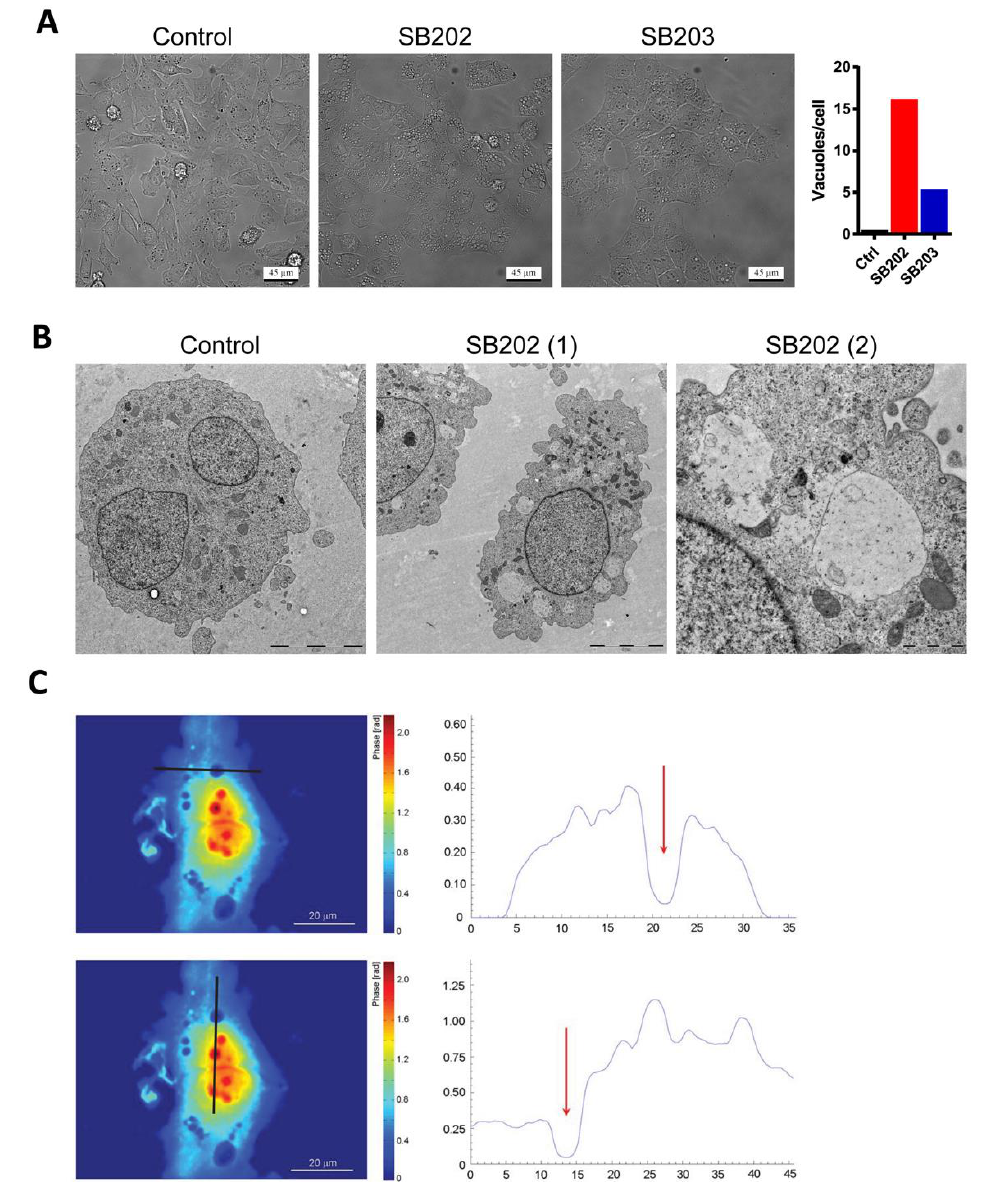
Figure 2. Pyridinyl imidazole compounds induce vacuolization of cytoplasm in BRAF-mutated human melanoma cells. A375 cells were treated with DMSO (control), SB202190 (SB202; 10 µ M), and SB203580 (SB203; 10 µ M). ( A ) Phase-contrast light microscopy of living cells after 12 h treatment with pyridinyl imidazole p38 MAPK inhibitors. Scale bar: 45 µ m. The representative graph shows the mean number of vacuoles per cell quantified using ImageJ / Fiji (find maxima—bright spots above a certain threshold). Dying rounded cells were excluded from the analysis. Similar results were obtained in three independent experiments. ( B ) The content of vacuole-like vesicles was visualized by electron microscopy 24 h post-treatment with SB202190 (SB202). Control and SB202(1)—scale bar 5 µ m. SB202(2)—scale bar 1 µ m. Two independent experiments showed similar results. ( C ) Quantitative phase-imaging analysis of cellular dry mass in melanoma cells treated for 12 h with SB202190. The zero level of dry mass density was defined as the density of the observation medium. The areal density distribution of the dry mass was quantified in profiles (right panels) indicated by dark lines. Red arrows highlight the position of vacuoles. Two independent digital holography microscopy experiments showed similar